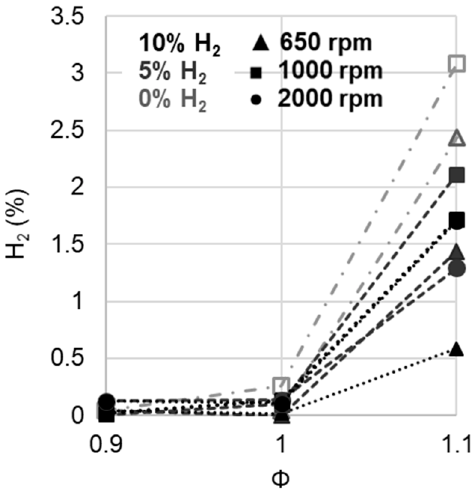
Figure 7. H 2 emissions vs equivalence ratio for different engine speeds and H 2 content in the fuel. Pin = 1 bar.